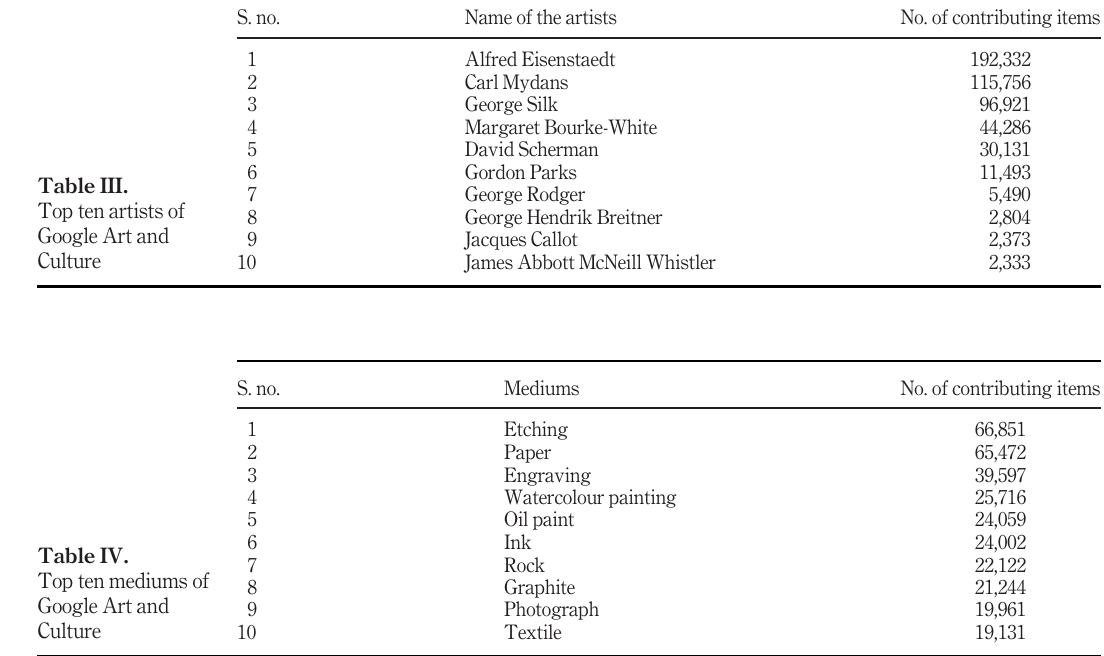
Table IV. Top ten mediums of Google Art and